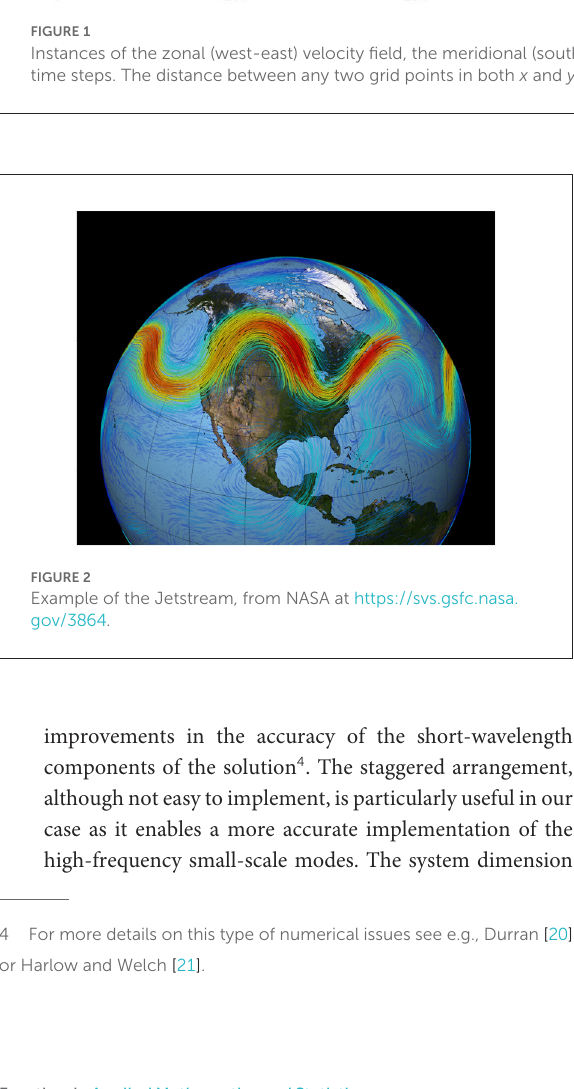
improvements in the accuracy of the short-wavelength components of the solution 4 . The staggered arrangement, although not easy to implement, is particularly useful in our case as it enables a more accurate implementation of the high-frequency small-scale modes. The system